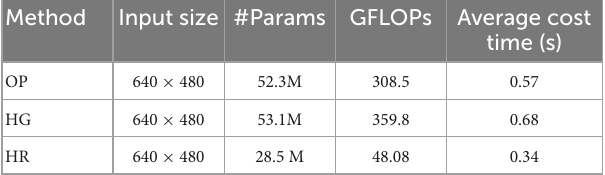
TABLE 2 FLOPs and average time cost on each